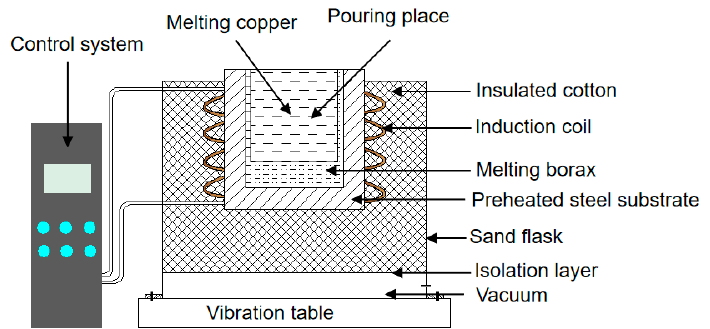
Figure 2. Schematic representation of the experimental equipment.